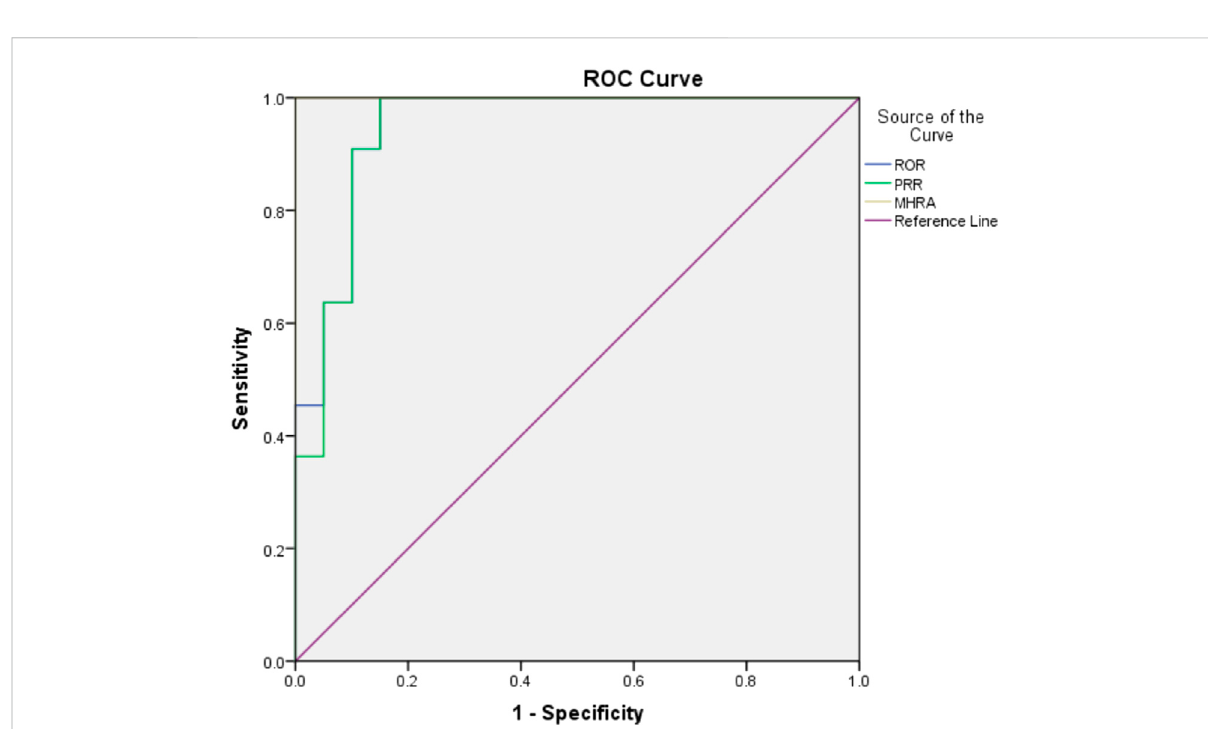
FIGURE 3 ROC curve of PRR, ROR and MHRA methods compared with BCPNN